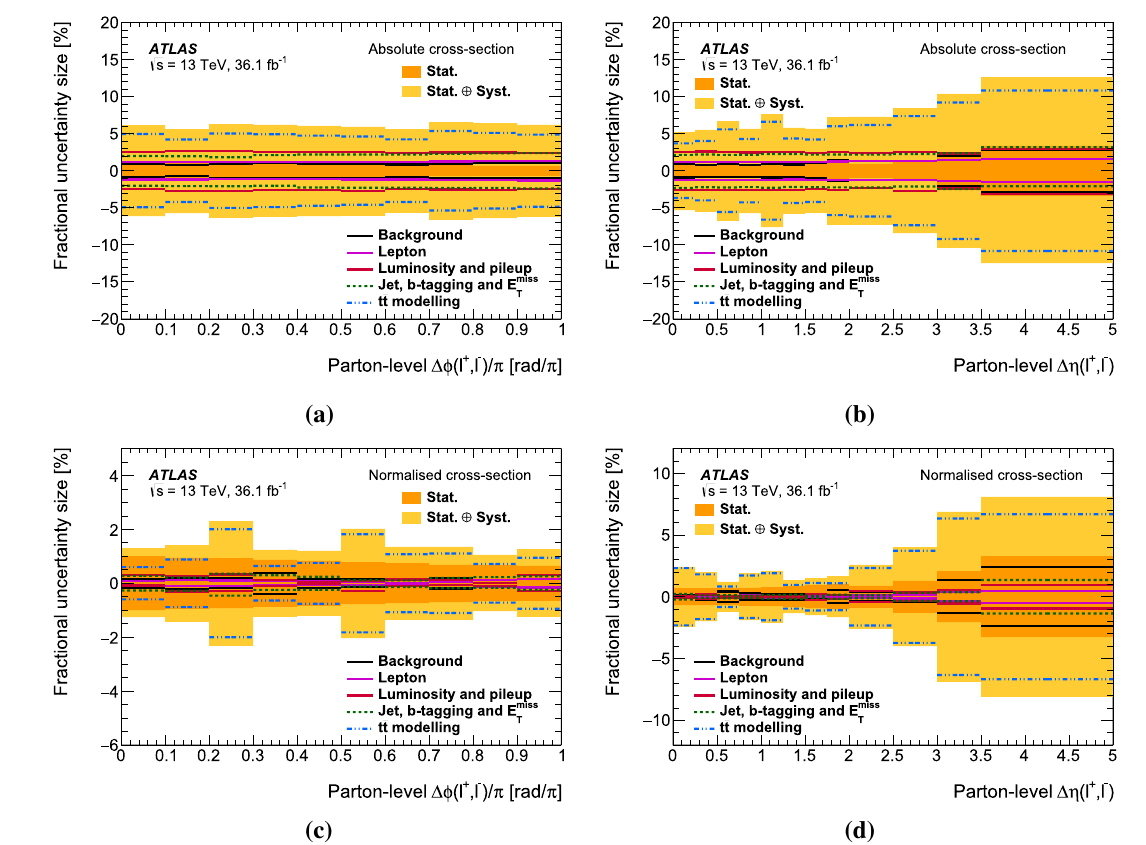
Fig. 7 Systematic uncertainties for the parton-level differential cross- sections: (top) , absolute a (cid:3)φ and b (cid:3)η and (bottom) , normalised c (cid:3)φ and d (cid:3)η . The t ¯ t modelling uncertainties refer to the contributions